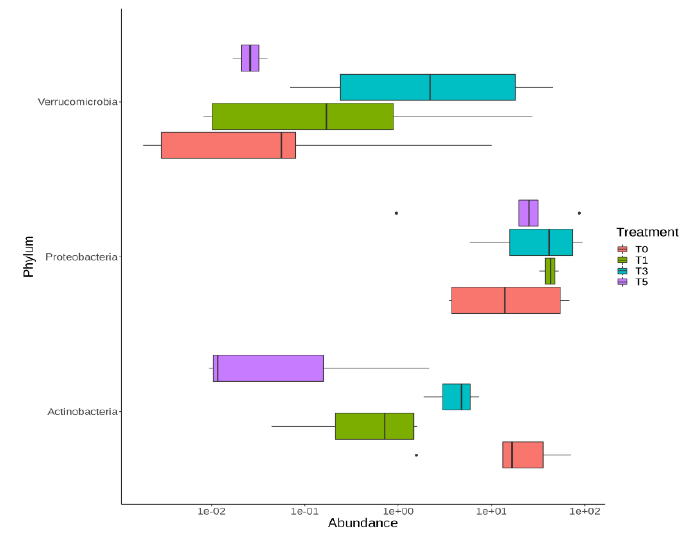
Figure 6. OTU distribution of the gut microbiota during the time-course of the CMA group computed by DeSeq2 test at phylum level. The interquartile range is represented by the box and the line in the box is the median. The whiskers indicate the largest and the lowest data points, respectively, while the dots symbolize outliers. Only statistically significant OTUs ( p < 0.05) are plotted.